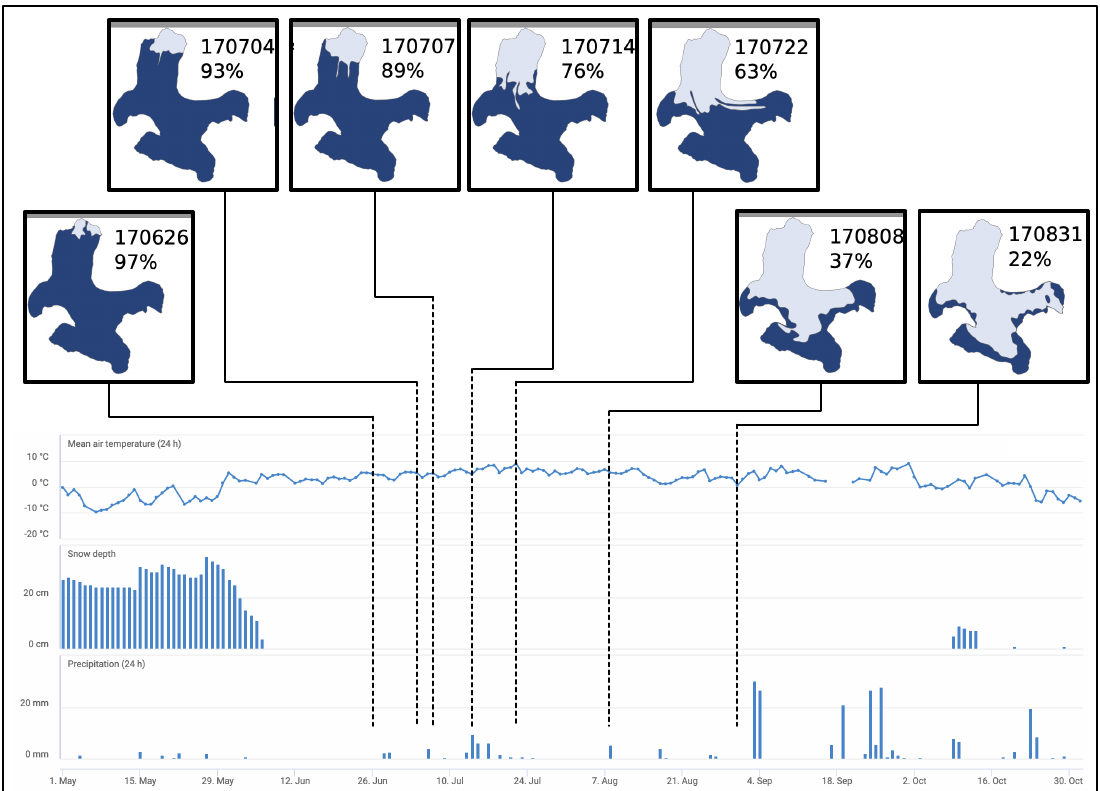
Figure 5. Snow cover evolution deduced from oblique-view ground-based pictures generated by monoplotting and then mapped on a DEM for azimuthal mosaicing ( top ), and meteorological proxies observed in Ny-Ålesund, air temperature, snow depth and and precipitations, matching the sharp snowpack evolution dates. Dates in the top images are indicated in YYMMDD format with YY the year, MM the month and DD the day.